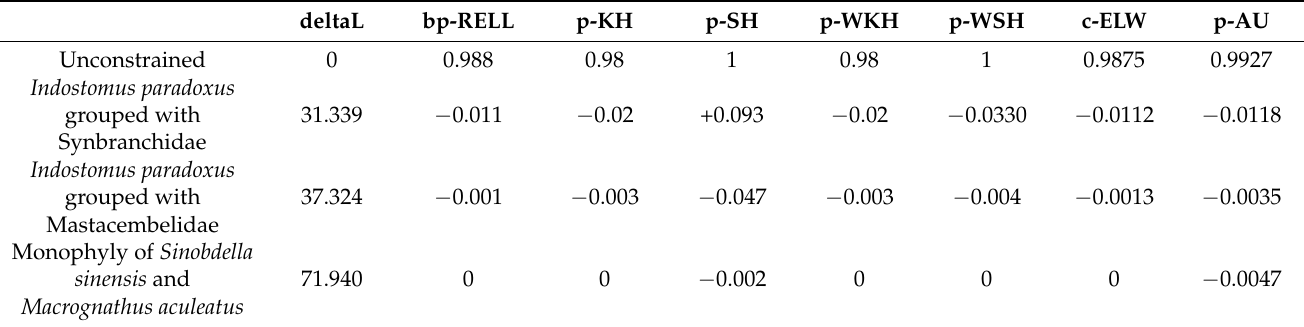
Figure 3. The phylogenetic tree for the order Synbranchiformes inferred from the 13 concatenated PCGs of 20 complete mitochondrial sequences obtained using MrBayes v.3.2.6 and IQ-TREE v.1.5.5. Channa gachua (NC_036948.1) was used as the outgroup. The new obtained mitogenome of M. albus breed is shown with grey background. The numbers at branches are Bayesian posterior probabilities and ultrafast bootstrap support values, respectively. GenBank accession numbers are given after the scientific name. Table 1. Constraint topology test results from IQ-TREE.